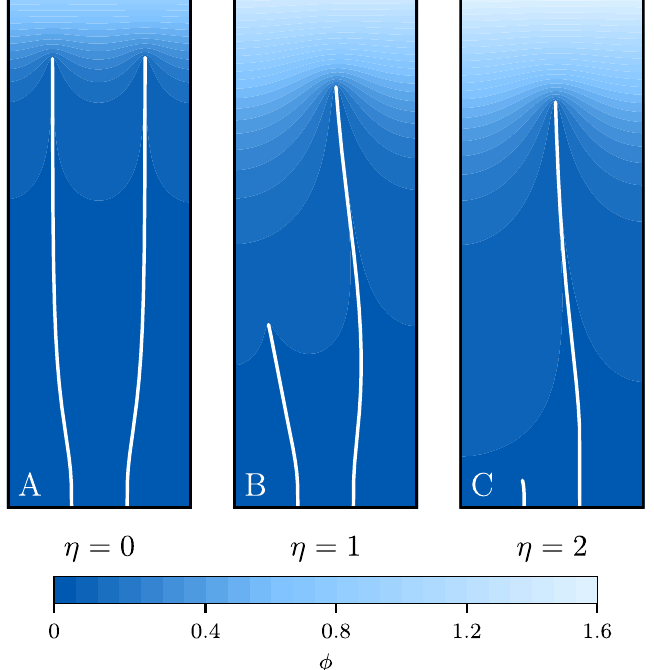
Figure 3. The evolution of two fingers for different growth exponents. Initially, the fingers are positioned symmetrically in the channel ( x initial = ± 0.3 ), but their heights differ (0.01 vs. 0.02). The units here are chosen in such a way that the channel extends from x = − 1 to x = 1 . ( A ) For η = 0 the fingers grow with the same velocity. ( B , C ) At larger η the growth becomes unstable due to the competition between the fingers for an available flux. The colors in the figure correspond to the value of the field driving the growth.